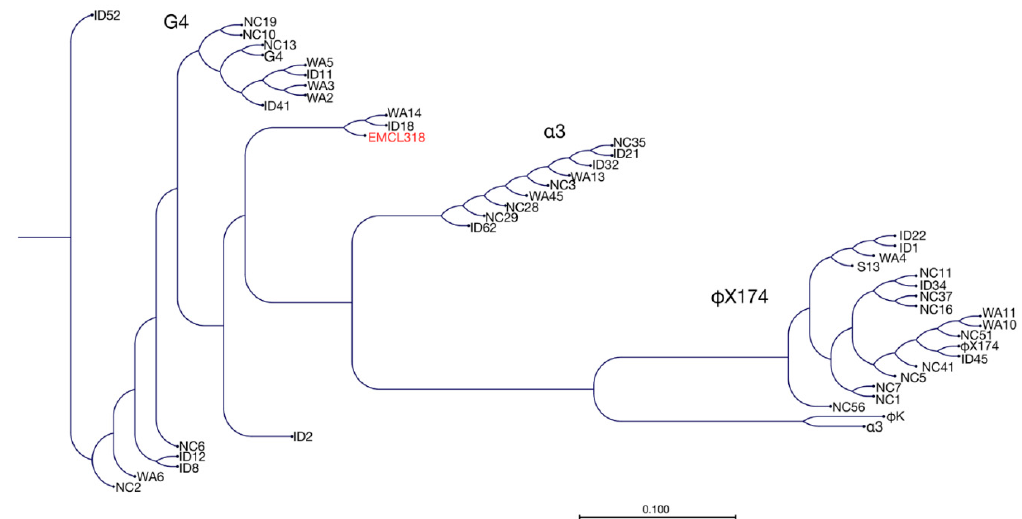
Figure 4. Phylogenetic relatedness among F proteins derived from different Microviridae . Neighbor-joining tree based on the deduced amino acid sequences from the F proteins using the CLC Sequence Viewer 7 platform (selected alignment by CanadianF alignment). The bootstrap test was performed with 100 replicates. The evolutionary distances were computed using the Jukes-Cantor method and are in the units of the number of amino acid substitutions per site. The protein EMCL318 retrieved highlighted in red.